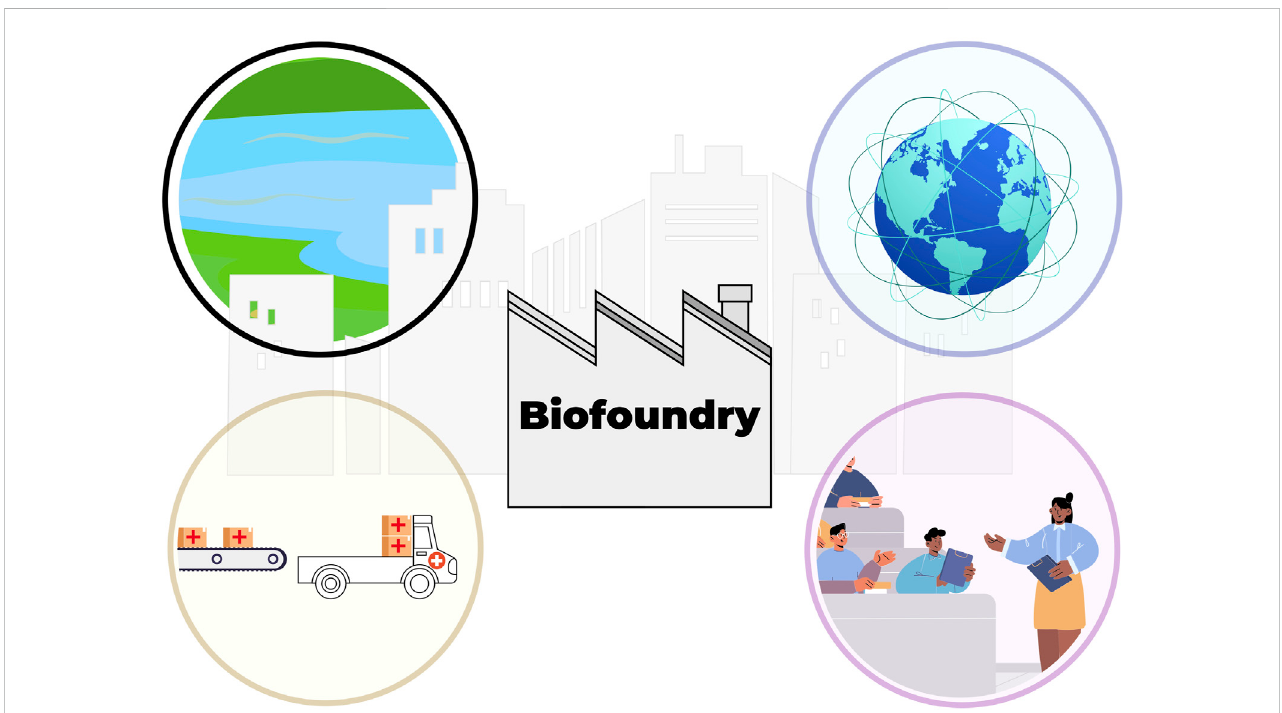
FIGURE 1 A vision for the future role of biofoundries and citizen science. Biofoundries are local hubs that are close to urban areas, and foster citizen engagement through citizen science (top left) and education (bottom right). Global network of biofoundries cooperates to share protocols and data (top right), which further strengthens the capacity of individual biofoundries to safeguard biosecurity and implement